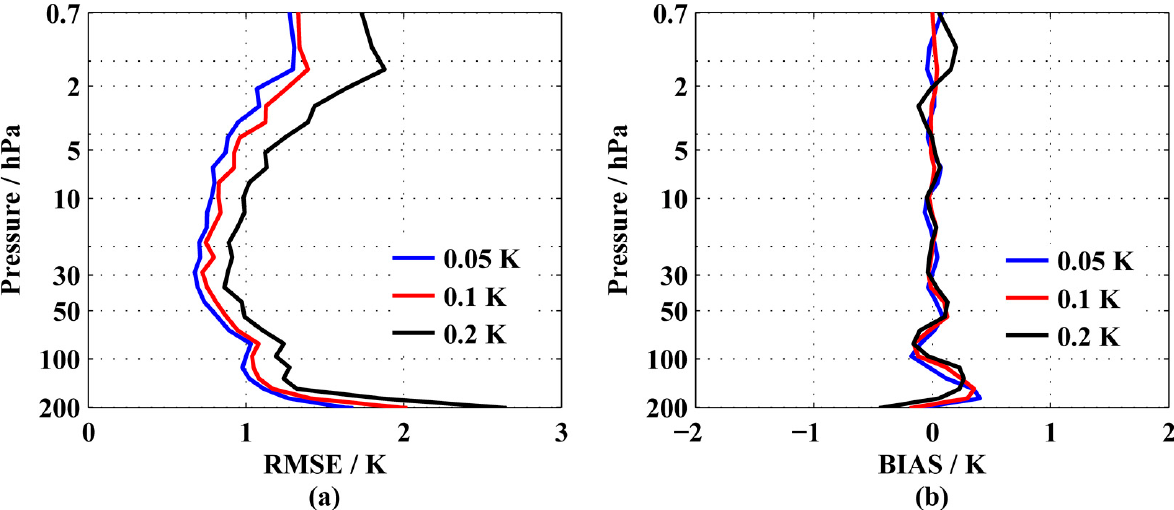
Figure 11. The retrieval results with different instrumental noise, the same spectral range (9.6 cm − 1 ), and the same spectral resolution (0.03 cm − 1 ). ( a ) RMSE of temperature. ( b ) BIAS of temperature.